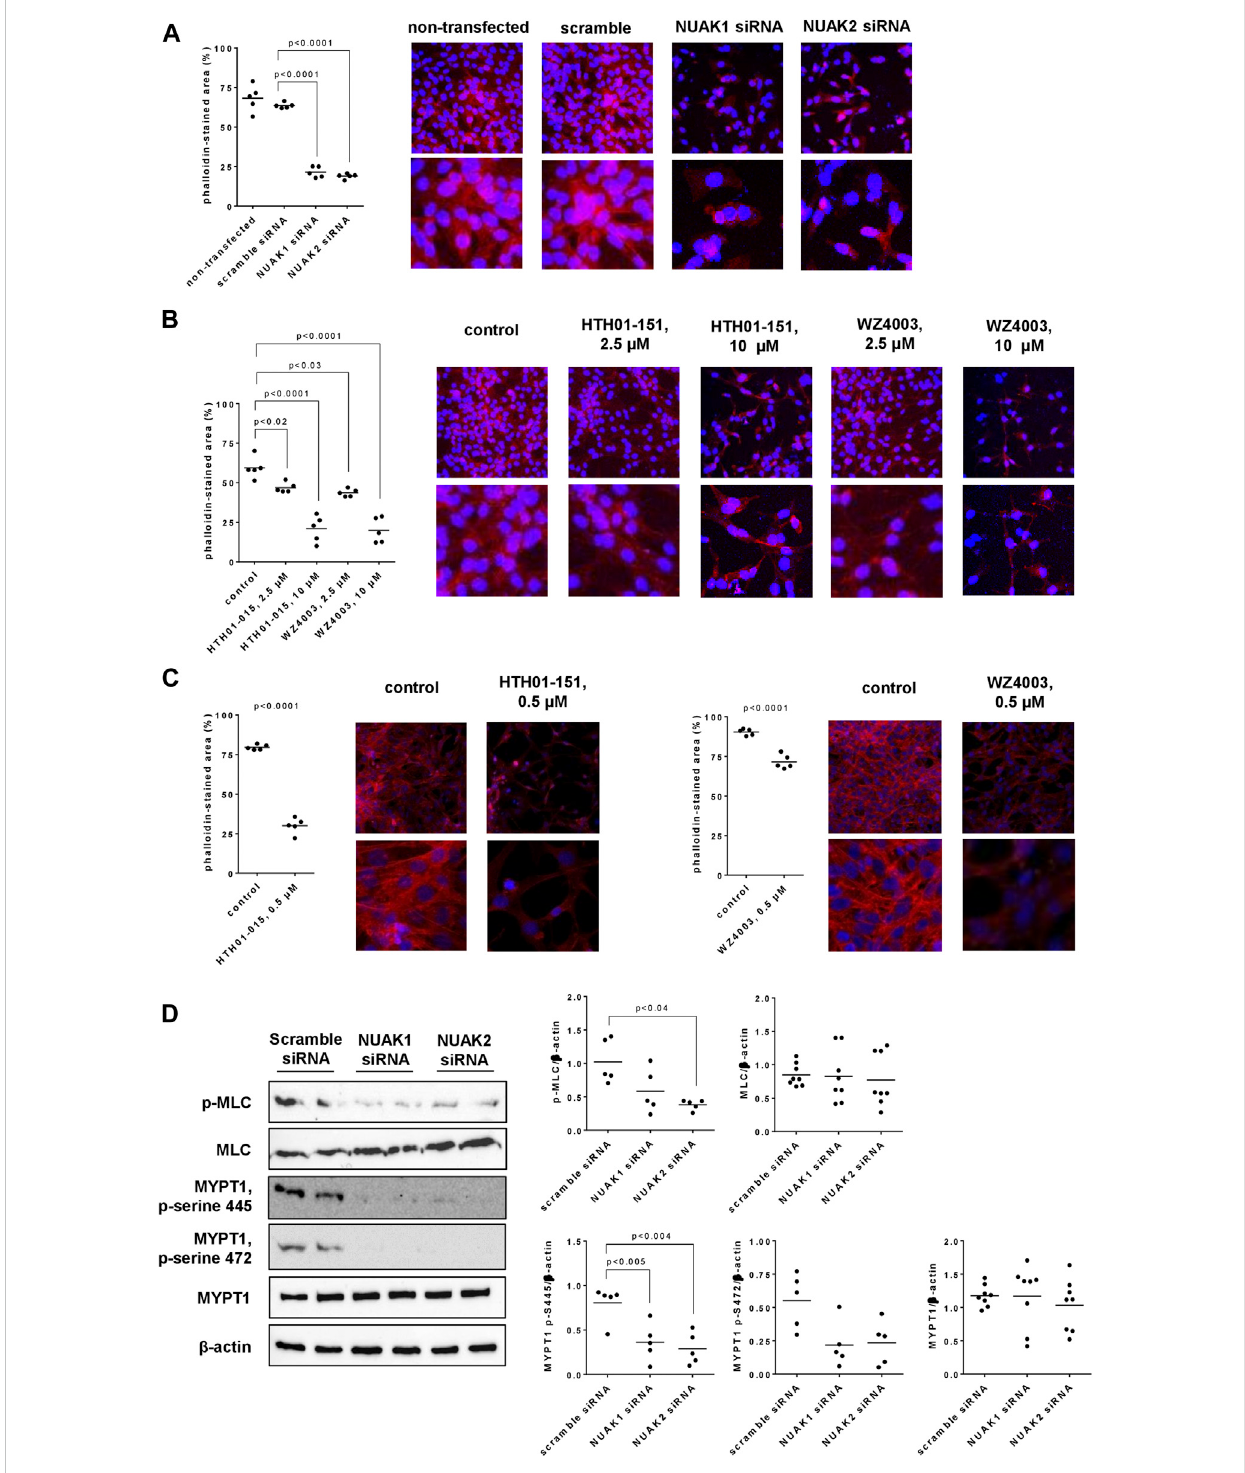
FIGURE 6 Actin organization and MLC phosphorylation in WPMY-1 cells. Actin organization was assessed by phalloidin staining (A – C) , and levels of phospho- MLC, MLC, phospho-MYPT1 and MYPT1 were assessed by Western blot analyses (D) . Phalloidin staining was performed 48 h after transfection with scramble siRNA or isoform-speci fi c NUAK siRNAs (A) , 24 h after addition of HTH01-015, WZ4003 or solvent to controls (B) , or 48 h after addition of HTH01-015, WZ4003 or solvent to controls (C) . Western blot analyses were performed with cells transfected with scramble siRNA or siRNAs for NUAK1 and -2 (D) . Shown are scatter plots including all single values from quanti fi cation of each independent experiment together with p values from one-way ANOVA with Tukey ’ s test in (A) , from one-way ANOVA with Dunnett ’ s test in (B) , from Student ’ s t -test in (C) , and from one-way ANOVA with Dunnett ’ s test in (D) , and representative experiments from phalloidin staining (pictures in lower panels are cutouts from pictures in upper panels) and representative Western